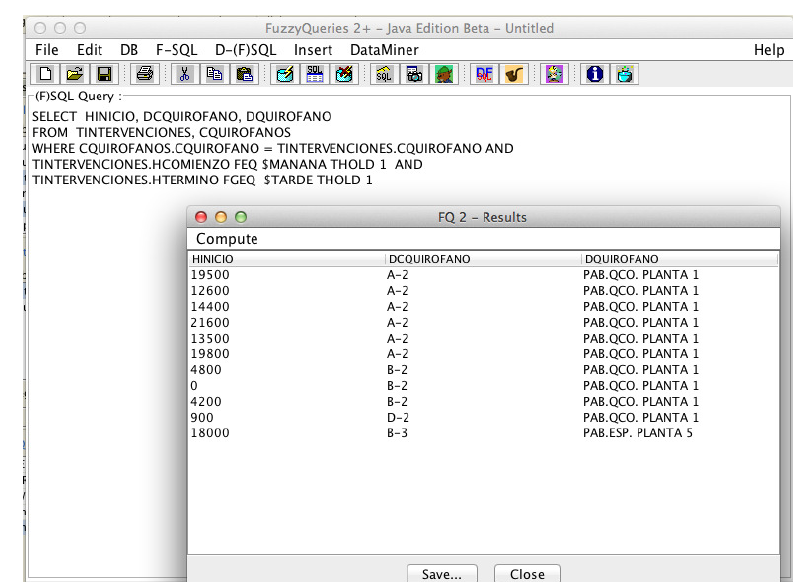
Fig. 11. Fuzzyqueries2